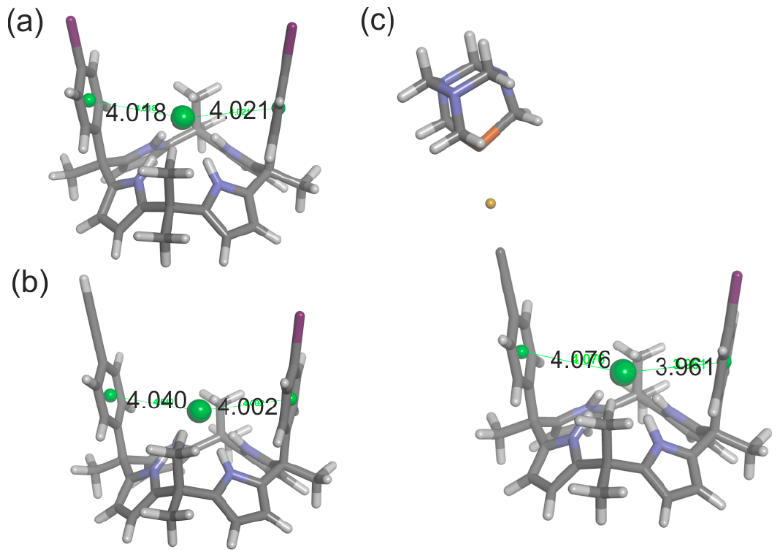
Figure 6. Energy minimized structures at the DFT level of theory of the chloride complexes of the receptor series: ( a ) 3 • Cl − ; ( b ) 2 • Cl − ; ( c ) 2Au • Cl − . The distances between the chloride anion and the centroids of the two aromatic rings are shown in Å. The receptors are depicted in stick representation and the chloride as scaled ball.